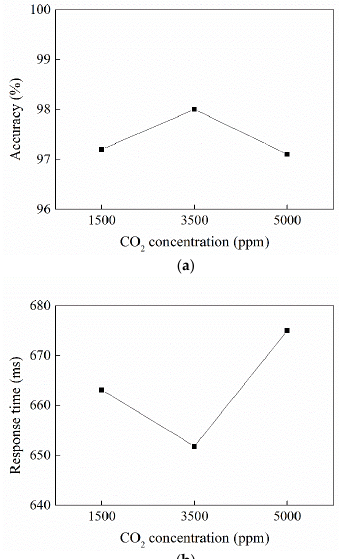
Figure 4. Performance metrics of the VS test under different CO 2 conditions; * ( p < 0.05), ** ( p < 0.01). ( a ) Accuracy. ( b ) Response time. ( c ) Missing report rate and false alert rate.